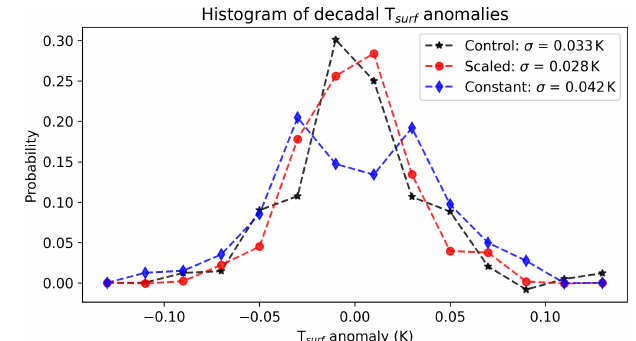
Figure 9. Histogram of decadally averaged surface temperature anomalies (K) in the control (black), scaled (red), and constant (blue)